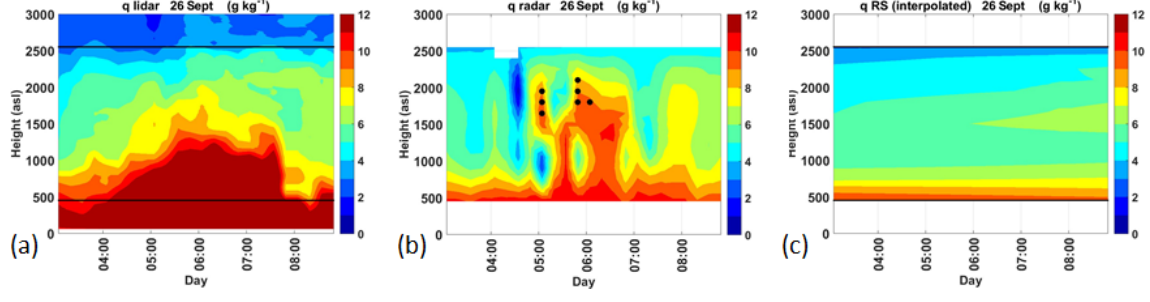
Figure 9. Same as in Fig. 7 for 26 September